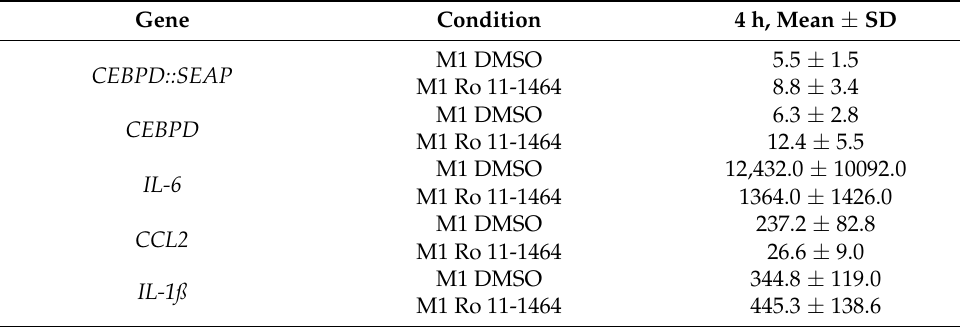
Table 3. Fold change (mean ± SD) for mRNA expression in Ro 11-1464-pre-treated target cells compared to M0 controls ( compare Figure 5).